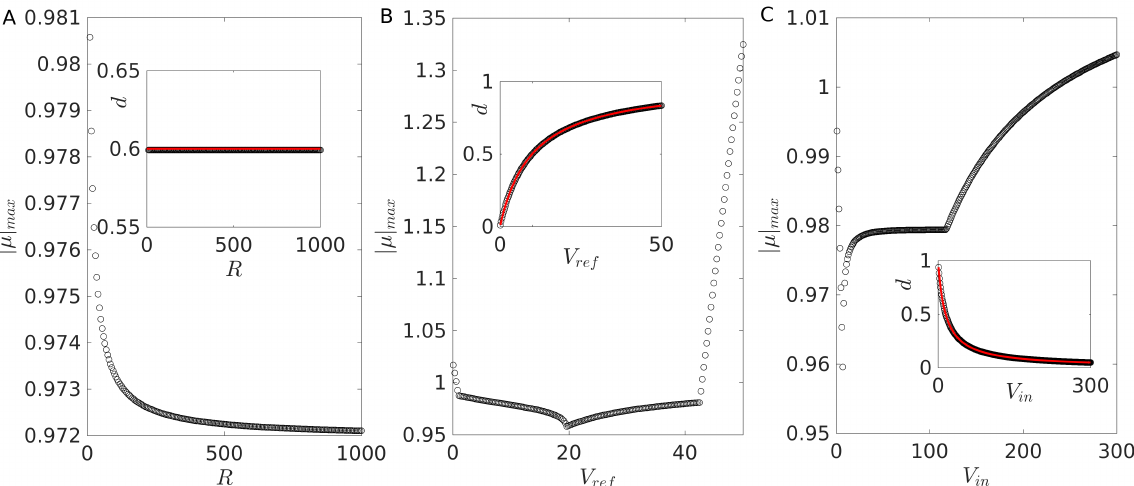
Figure 4. Norm of the maximal Floquet multiplier as a function of different bifurcation parameters: ( A ) R ; ( B ) V ref ; ( C ) V in . In all panels, the inset shows the solution of the duty cycle which solves the self-consistent Equation (18) (symbols) and the corresponding steady state expected solution (4) (red).